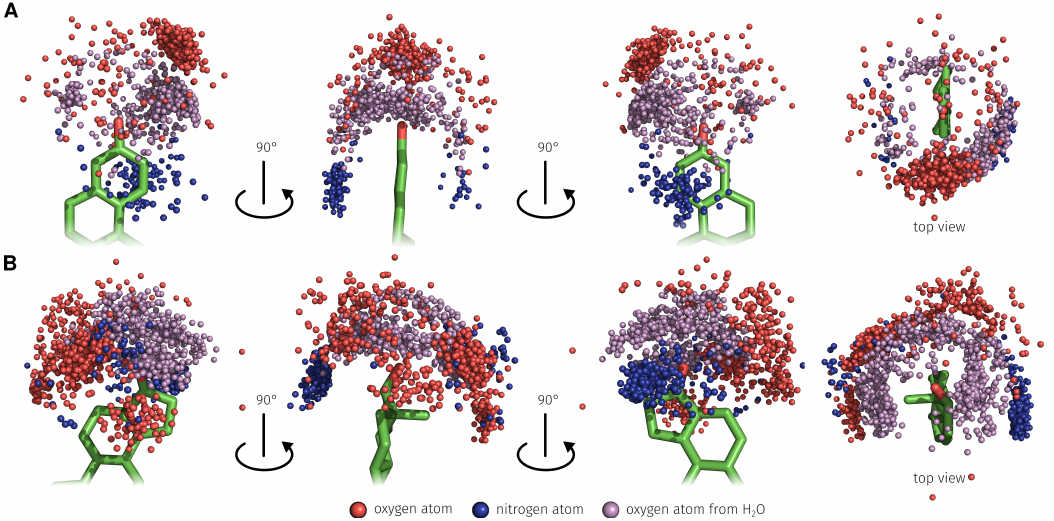
Figure 9. Distribution and different perspectives of the detected base interaction atoms during the 25 ns MD simulation that formed O–H · · · O–H · · · O (red, purple, and red atoms) and N–H · · · O–H · · · O (blue, purple and red atoms) water-mediated H-bonds. ( A ) The focus is on the 3-position of E2. ( B ) The focus is on the 17- β -position of E2. E2, 17 β